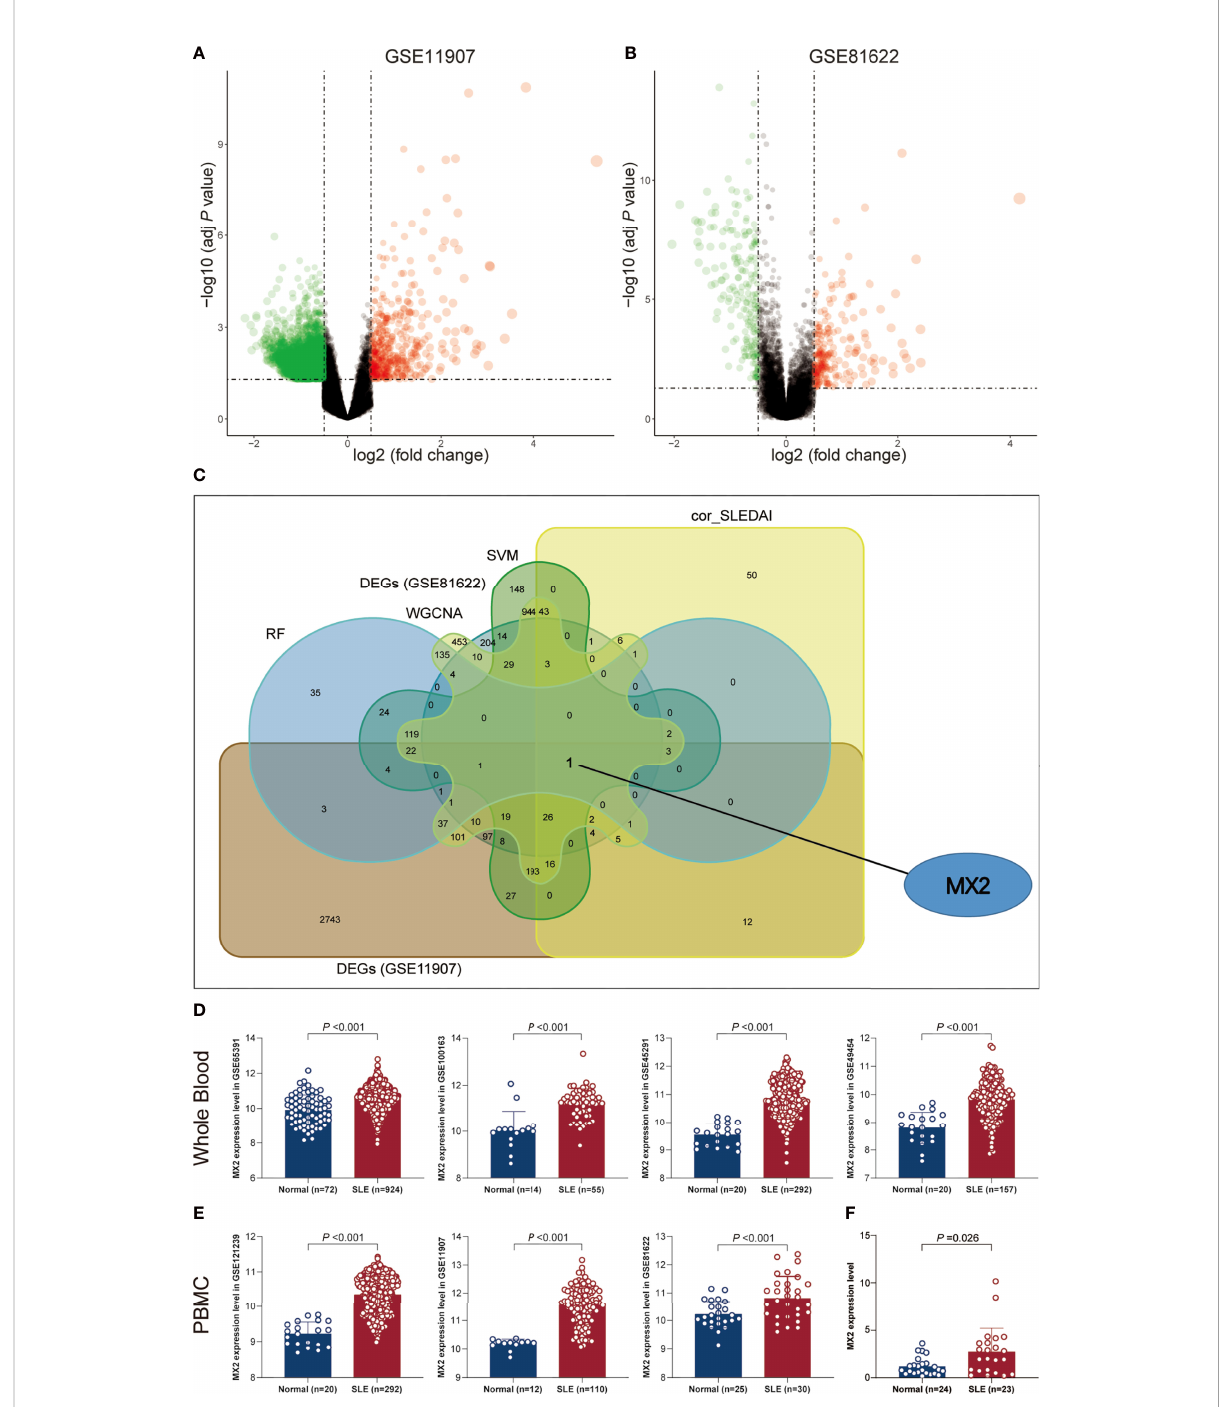
FIGURE 3 SLE biomarker screening. (A) Volcano plots of DEGs distribution in GSE11907. (B) Volcano plots of DEGs distribution in GSE81622. (C) Venn diagram showed the intersection of candidate biomarkers obtained by the fi ve algorithms. (D) Expression levels of MX2 in SLE and normal donors in different whole blood datasets. (E) Expression levels of MX2 in SLE and normal donors in different PBMC datasets. (F) The MX2 expression was validated by